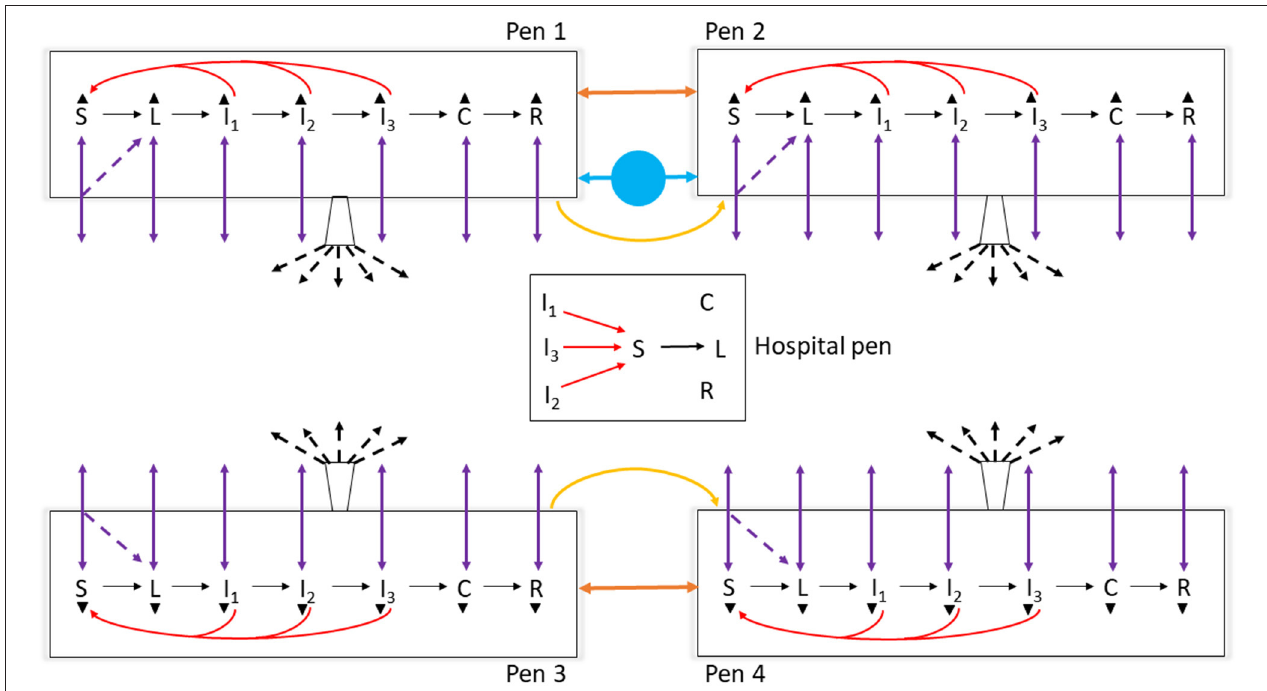
FIGURE 1 | Schematic diagram of the model of foot-and-mouth disease (FMD) virus transmission and FMD clinical manifestation dynamics in cattle within home-pens and among home-pens in a beef cattle feedlot. S, susceptible; L, latent; I 1 , subclinical infectious; I 2 , subclinical infectious; I 3 , clinical infectious; C, clinical but no longer infectious; and R, non-infectious clinically recovered. The black solid arrows show the home-pen subpopulation progression through the infection and disease stages. The red solid arrows show the virus transmission via direct contact between infectious to susceptible cattle in the home-pens and hospital-pen. The purple solid arrows show the animal movements from home-pens to the hospital-pen and back to the home-pens, and the purple dotted arrows show the possibility that susceptible animals moved acquired infection in the hospital-pen and returned as latent to the home-pens. The orange solid arrows show the virus transmission via animal direct contact fence-line. The yellow solid arrows show the virus contaminated material transmitted by pen-riders. The blue circle with solid arrows shows the virus transmission via contaminated water-troughs shared by home-pens. The buckets with black dotted arrows represent the airborne virus transmission. The black triangles represent animal mortality in each of the infection and disease